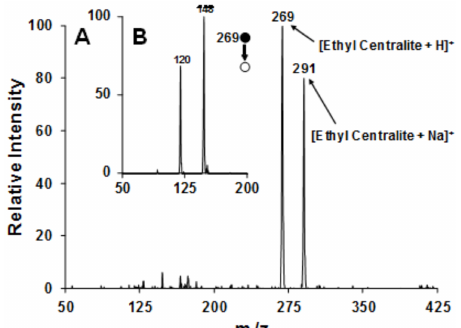
Figure 7. ( A ) STSI-MS spectrum collected after swabbing a trace, surface-bound residue of ethyl centralite, an organic component of gunshot residue. Both protonated ( m / z 269) and sodiated ( m / z 291) ethyl centralite is observed, as alkali earth metals can be abundant from authentic sample matrices and surfaces. ( B ) STSI-MS/MS of protonated ethyl centralite ( m / z 269), yielding a simple, yet highly specific fragmentation